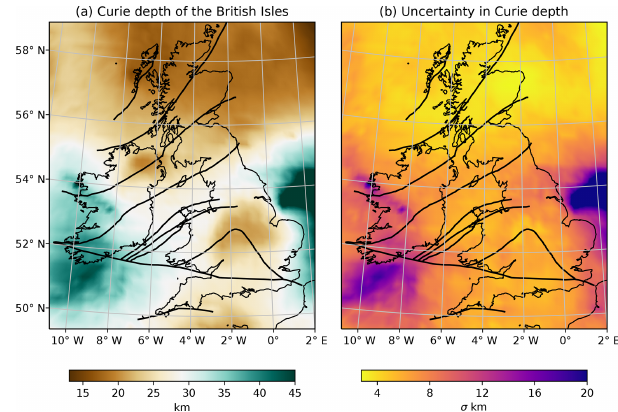
Figure 6. MAP estimate of Curie depth in the British Isles and its uncertainty; (a) Curie depth map is computed from 3900 centroids for a lateral resolution of 20km; (b) Uncertainty is given as 1 stan- dard deviation from the mean.